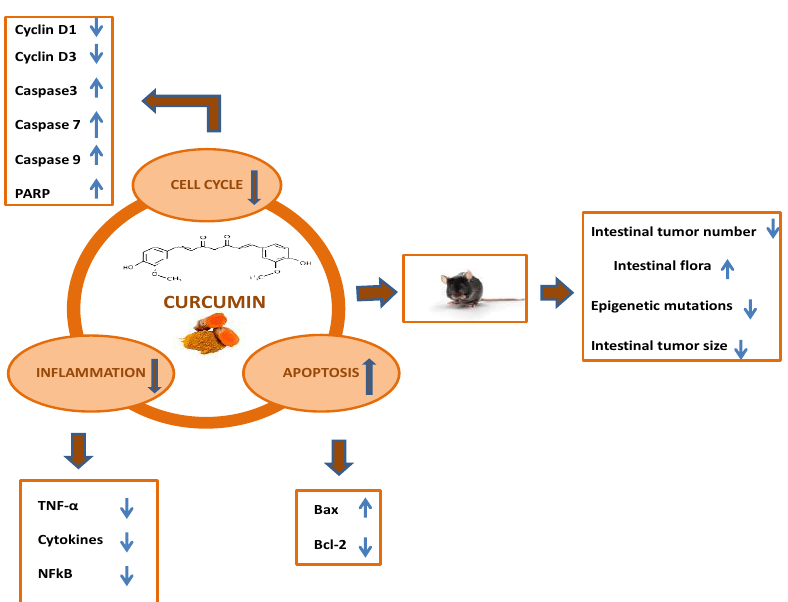
Figure 1. Chemoprevention of colorectal cancer by curcumin in animal models: Main mechanistic pathways.